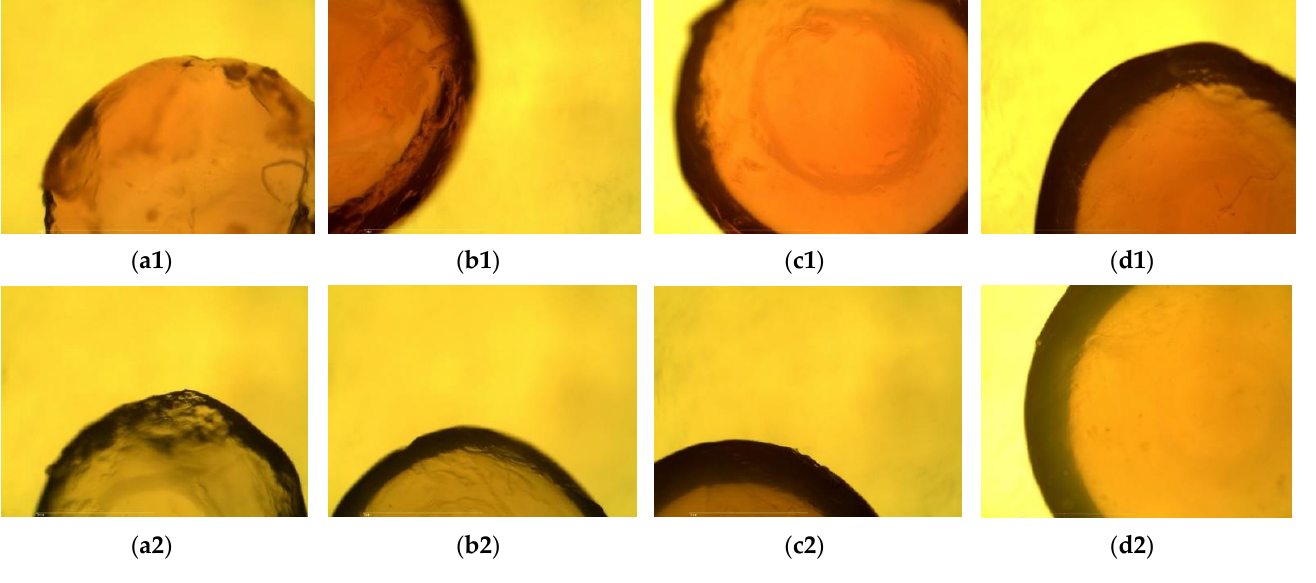
Figure 4. Micrographs of the bead cross-sections before (beads made with dye solution) and after the desorption process (beads after the dye release): 1%, 2%, 3% and 4% dye loaded beads before desorption ( a1 – d1 ); 1%, 2%, 3% and 4% beads after dye desorption ( a2 – d2 ).